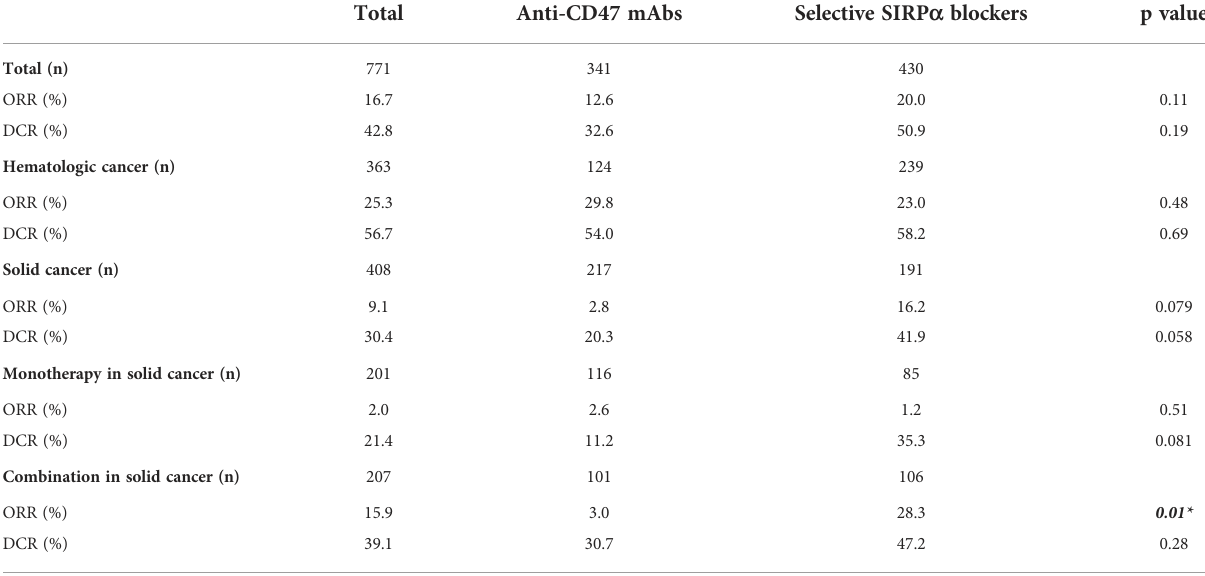
TABLE 2 Pooled patient-level data on the ef fi cacy of CD47-SIRP a inhibitors in clinical trials.